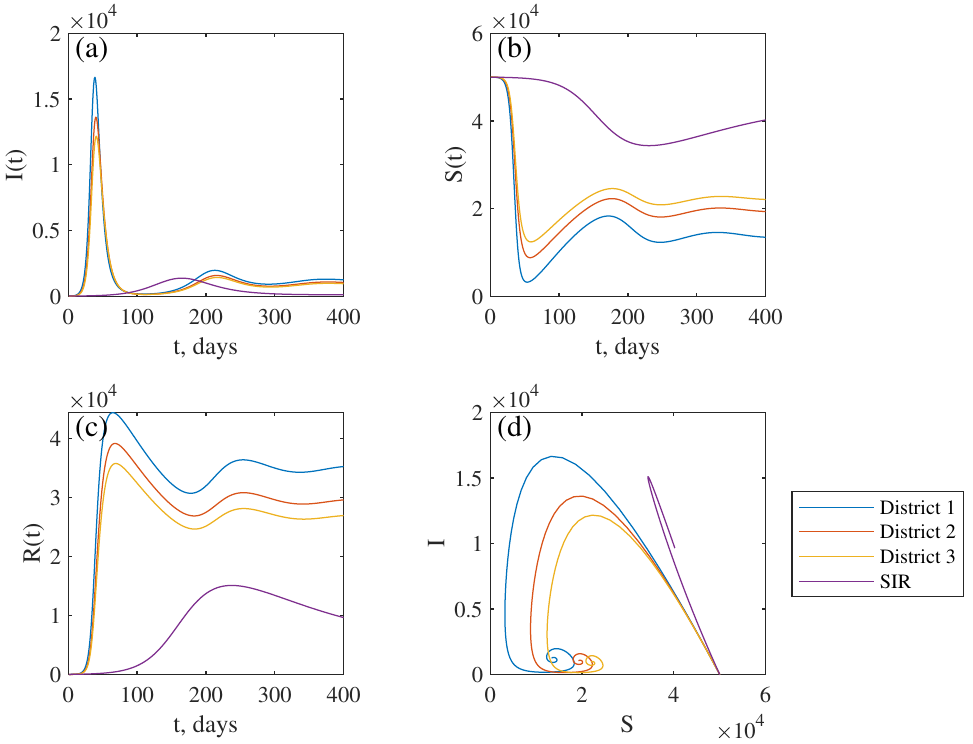
Figure 2. The time series of infected ( a ), susceptible ( b ) and recovered ( c ). The phase portrait for three districts ( d ), obtained for the values of the system parameters with the communication matrix (7): n = 50,000, β = 1.9, γ = 1.5, δ = 0.05, b = 0.01, d = 10 − 7 ; the violet line represents time series unaltered SIR model with the same